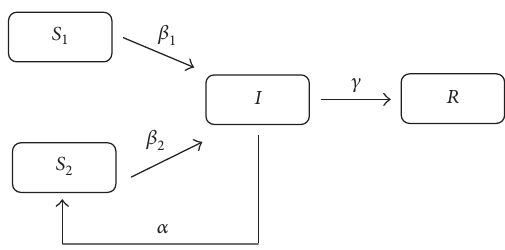
Figure 1: Flow chart of individual transfer among different